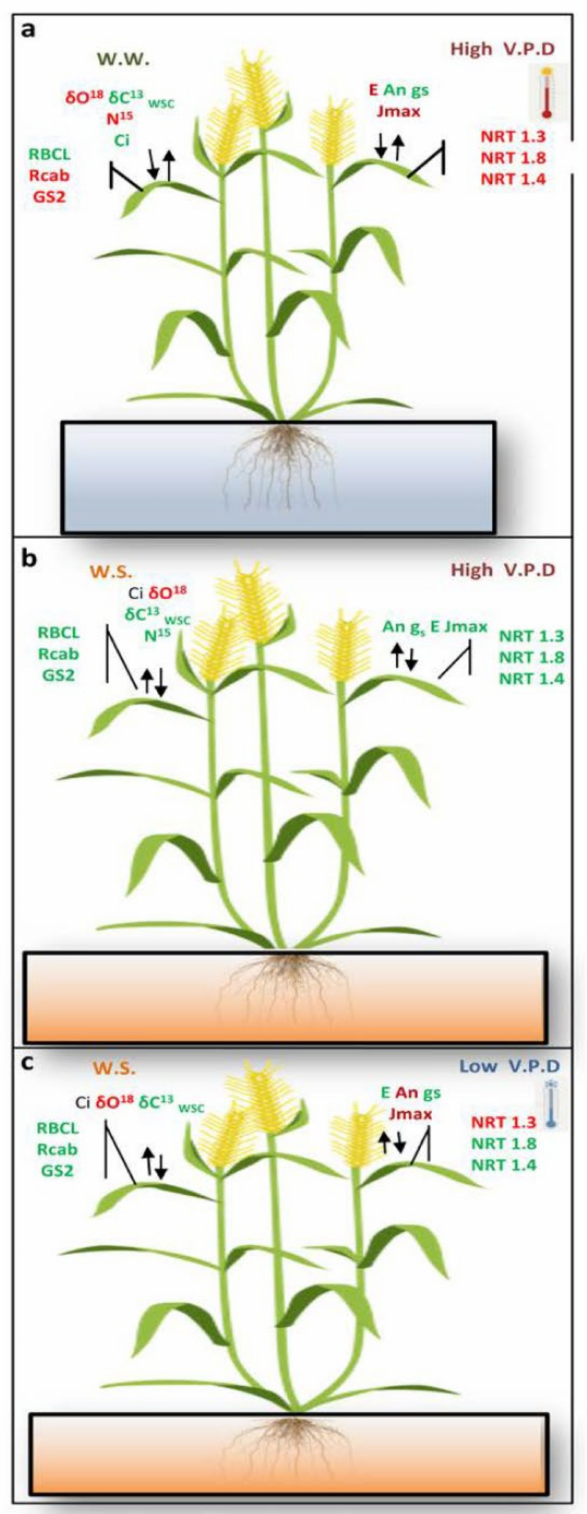
Figure 5. Model for whole plant C and N metabolism in durum wheat plants grown under low/high atmospheric VPDs and water availability: ( a ) well watered plants grown under high atmospheric VPD, ( b ) plants grown in drought conditions and high atmospheric VPD, ( c ) plants under wa- ter stressed conditions and low atmospheric VPD. Colors indicate either decreases (green) or in- creases